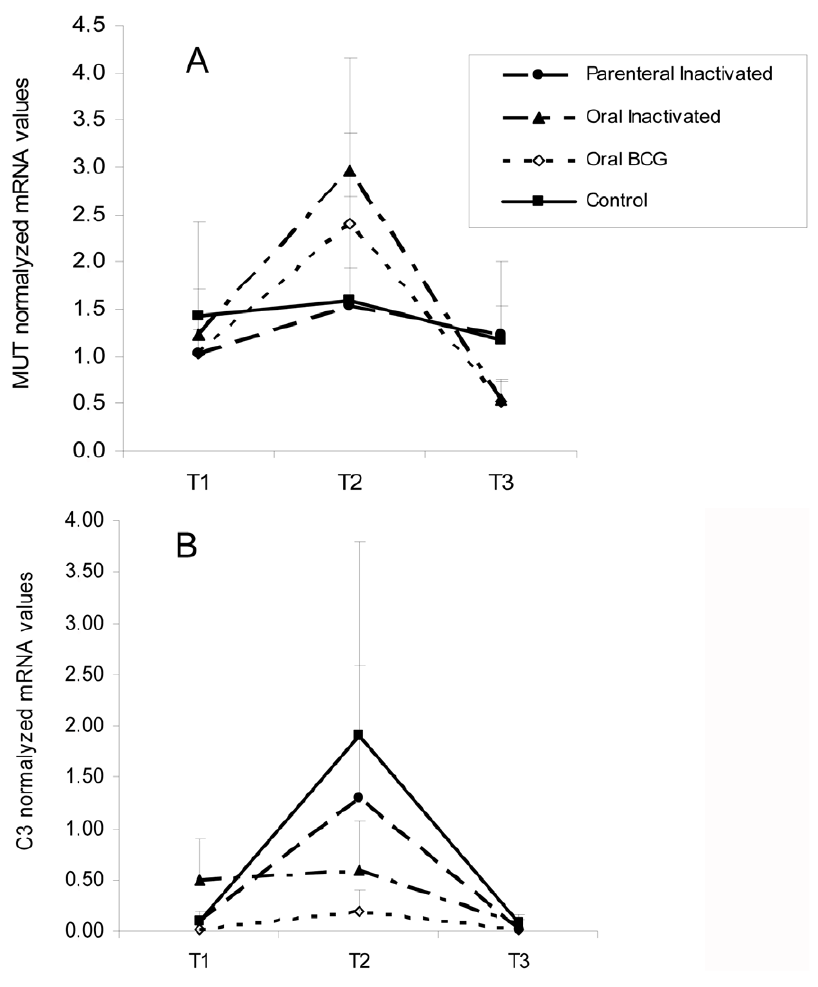
Figure 5. Quantitative MUT and C3 gene expression analysis in PMBC using qRT-PCR. Quantitative MUT (panel A) and C3 (panel B) gene expression analysis in PBMC of vaccinated wild boar and controls using qRT-PCR. Results were recorded as mRNA levels after normalization for cyclophilin gene expression using the 2- DD Ct method for each of the three time points (T1: before vaccination, T2: before challenge, T3: end of the experiment). Values are shown as average 6 SD.